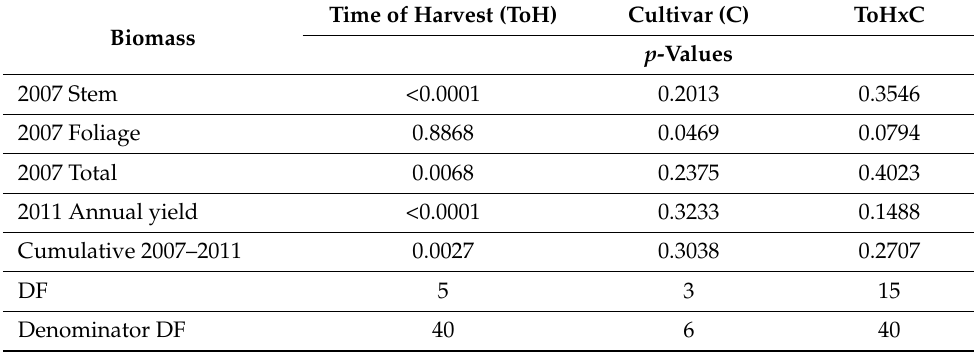
Table 3. Summary of analyses of variance for the effects of time of harvest, cultivar, and ToHxC on biomass production following first rotation time of harvest treatments. Main effects significance tested at α = 0.05. DF is degrees of